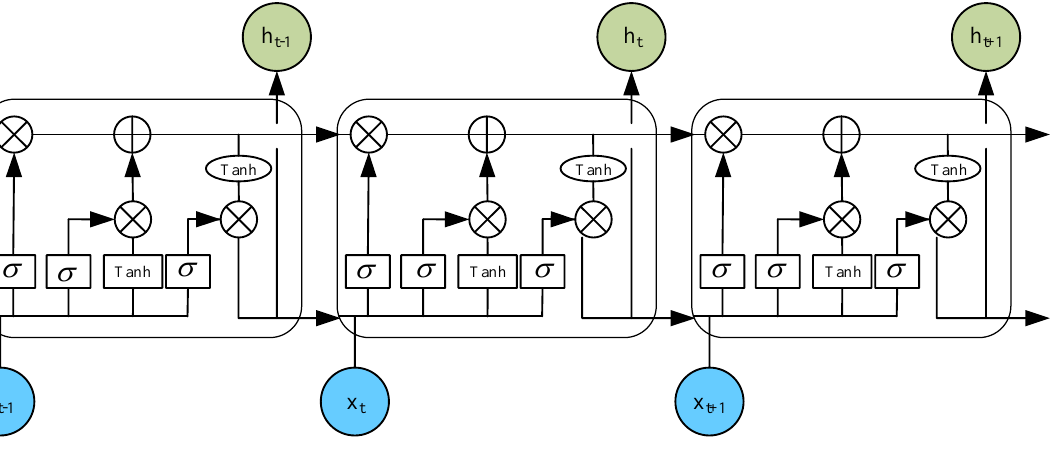
Figure 7. LSTM structure.